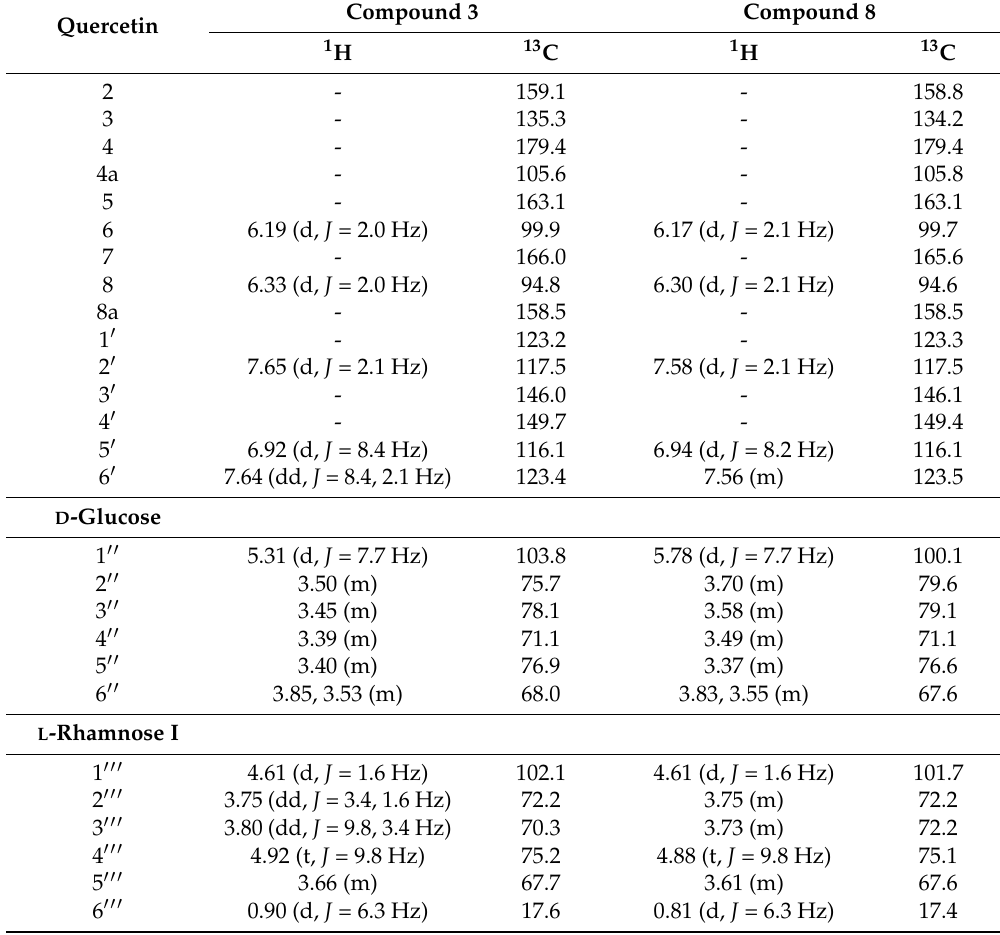
Table 2. 1 H and 13 C spectral data of compounds 3 and 8 (CD 3